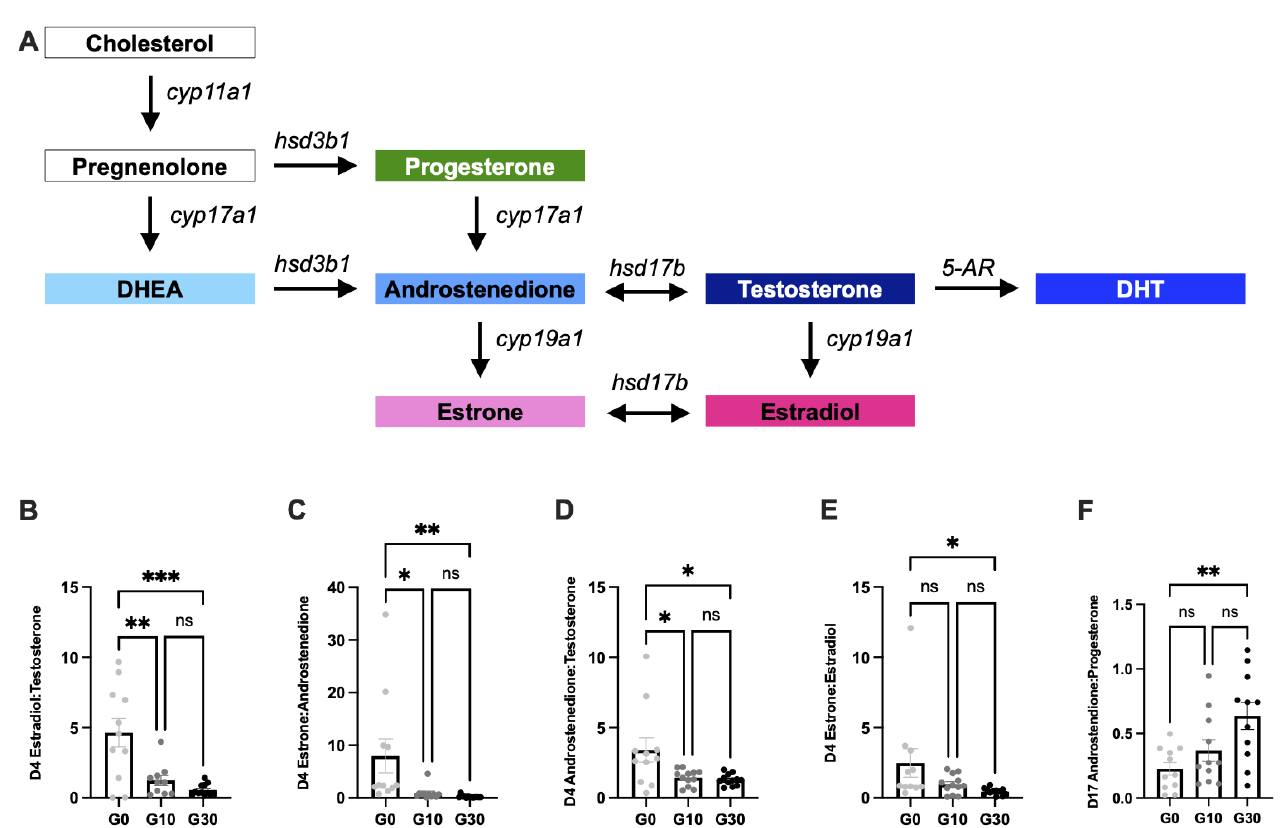
Figure 4. Steroid hormone ratios indicate differences in enzyme activity in G30 group. ( A ) The steroidogenesis pathway and the murine enzymes involved in each step of steroidogenesis. ( B ) ratio of estradiol to testosterone concentration measured on culture day 4 (D4). ( C ) Ratio of estrone to androstenedione concentration measured on culture day 4 (D4). ( D ) Ratio of androstenedione to testosterone concentration measured on culture day 4 (D4). ( E ) Ratio of Estrone to estradiol concen- tration measured on culture day 4 (D4). ( F ) Ratio of androstenedione to progesterone concentration measured on culture day 17 (D17). Data are presented as the mean ± SEM. n = 11–12 samples/group. Statistical significance determined with one-way ANOVA with Tukey’s multiple comparison test and/or post hoc test for linear trend. ns signifies not statistically significant, * signifies p < 0.05, ** signifies p < 0.01, and *** signifies p < 0.001. G0 = standard media (no hCG), G10 = physiologic ratio